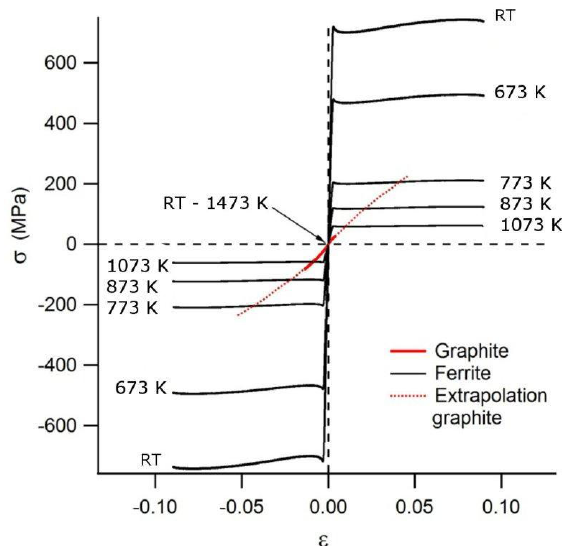
Figure 9. Schematic mechanical properties of the ferrite and graphite as a function of temperature (after data given in